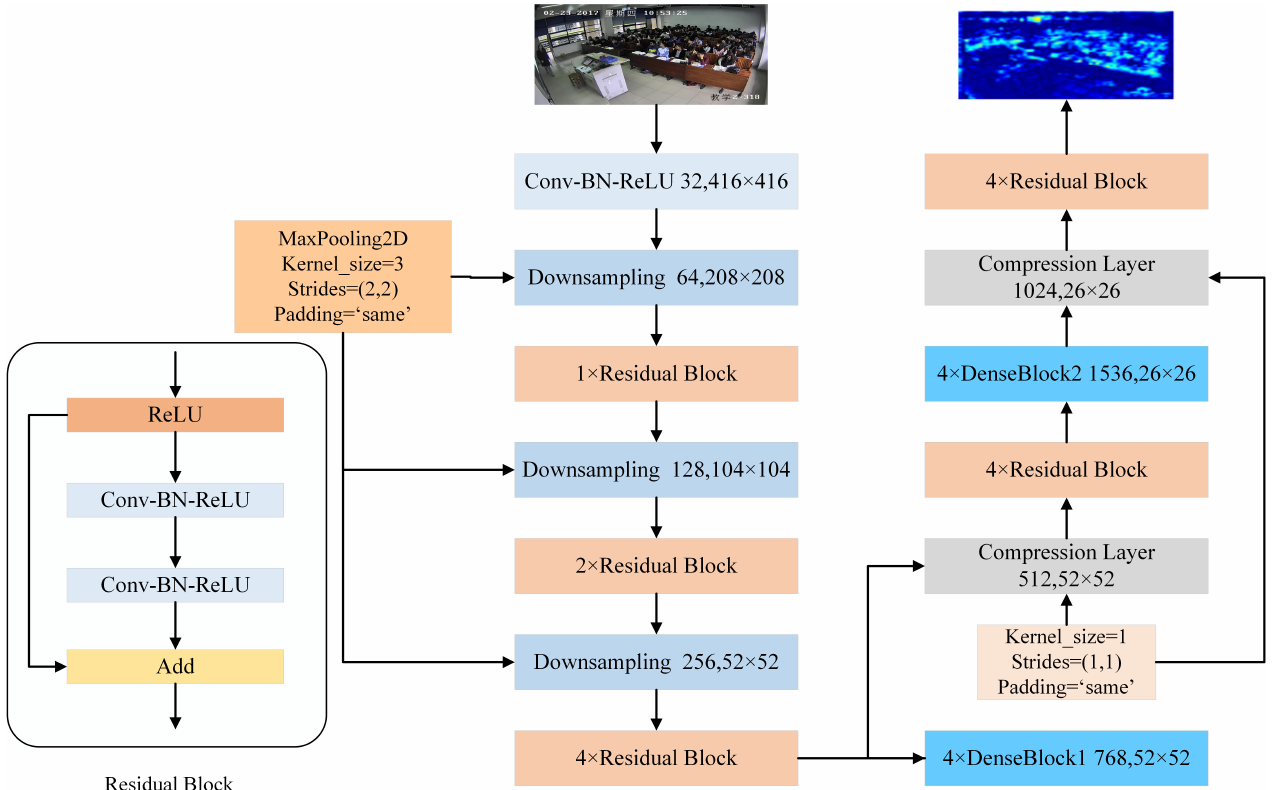
Figure 3. The structure of the DR-Net feature extraction network.